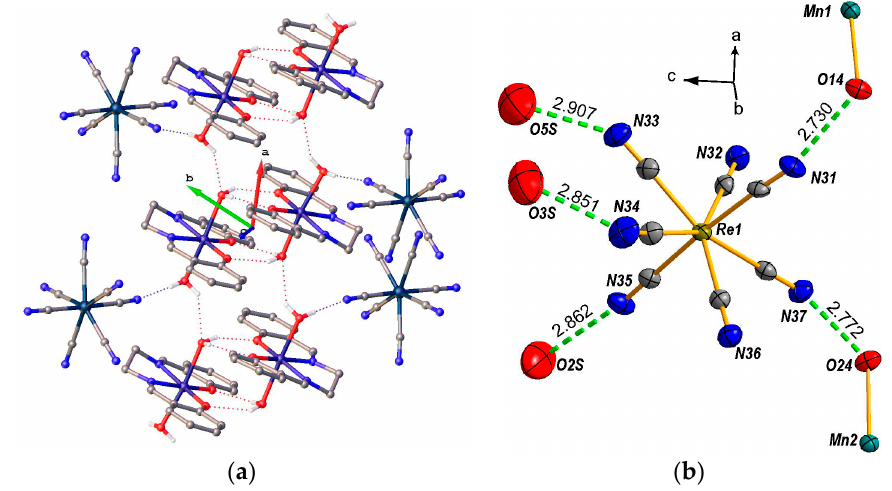
Figure 3. Hydrogen bonds in compound 3 : ( a ) a supramolecular column composed of the [Mn( 3MeO Salen)(H 2 O) 2 ] + cations; ( b ) hydrogen bonds of the anion [Re(CN) 7 ] 3 − . Selected mean interatomic distances (Å) and angles (deg) for the complex: Re–C 2.104(4), C–N 1.1477(5), C eq –Re–C eq 72.06(14), C ax –Re–C eq 90.19(14), C ax –Re–C ax 175.46(14), Re–C–N 178.2(4).